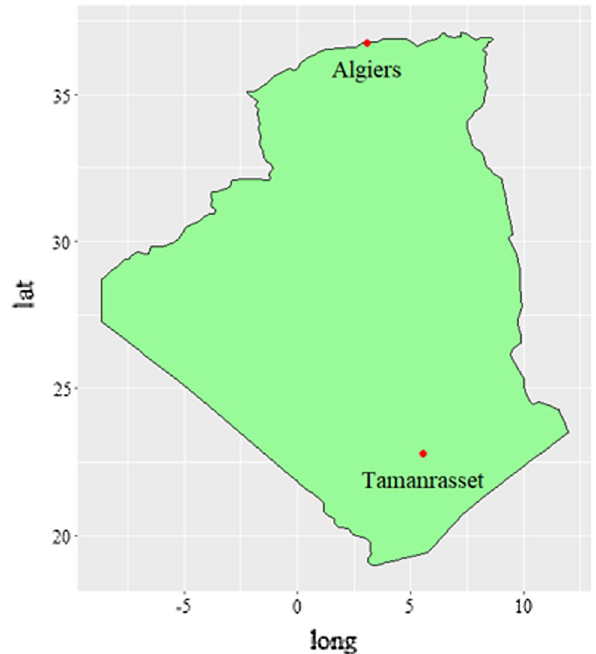
Fig. 1 Location of Tamanrasset